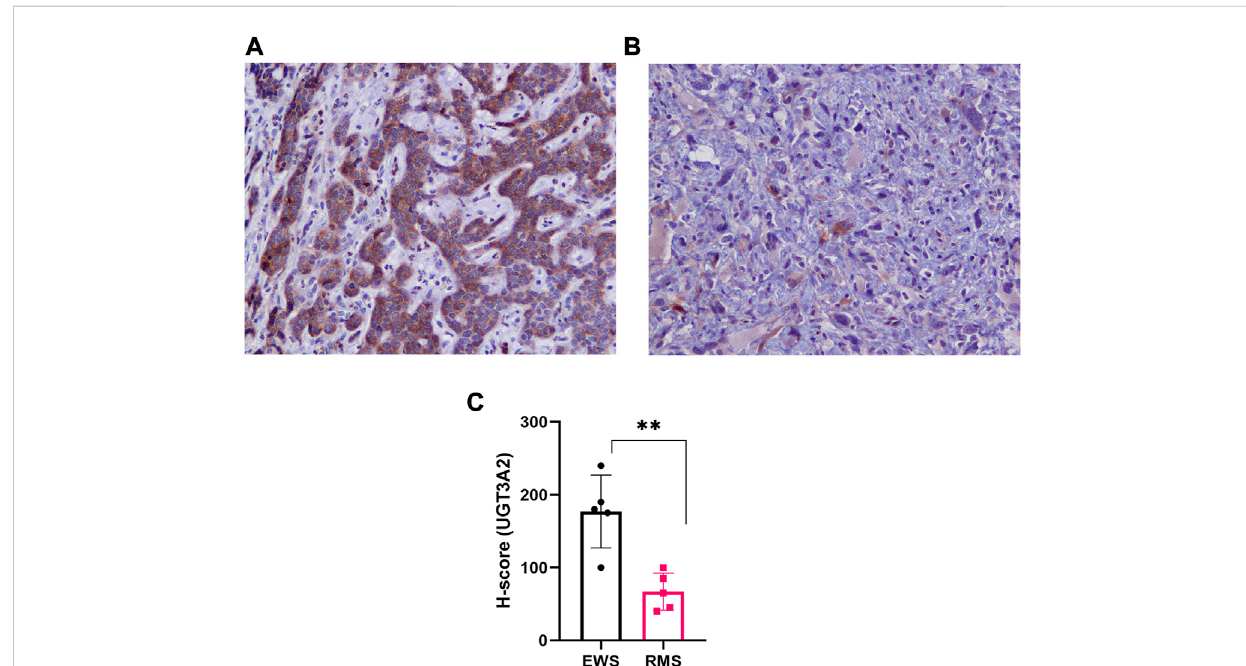
FIGURE 6 Immunohistochemical Staining for UGT3A2Expressionin Patient TumorSections.Representative IHC (20X images) ofrepresentative patient tumor tissue sections indicating strong UGT3A2 staining in (A) EWS compared to (B) Rhabdomyosarcoma samples. (C) H-score was calculated for EWS ( n = 5), and RMS ( n = 5) patient tissue sections based on UGT3A2 expression and is represented as bar graph. EWS samples demonstrated higher expression of UGT3A2 as compared to RMS tumor sections (** p = 0.0024 assessed by